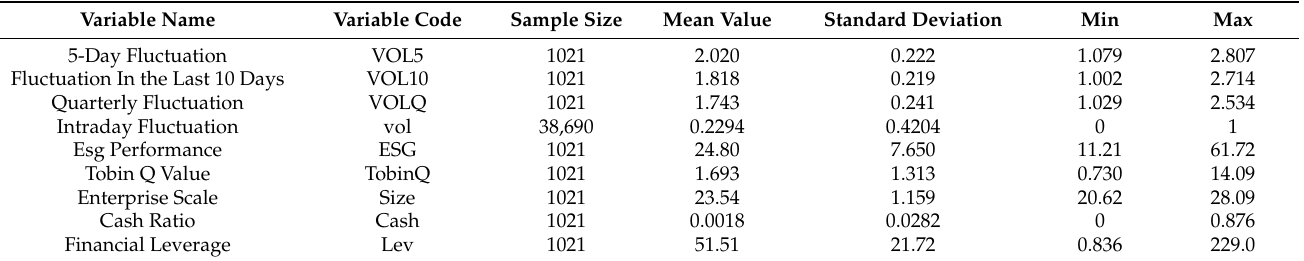
Table 2. Descriptive Statistics.